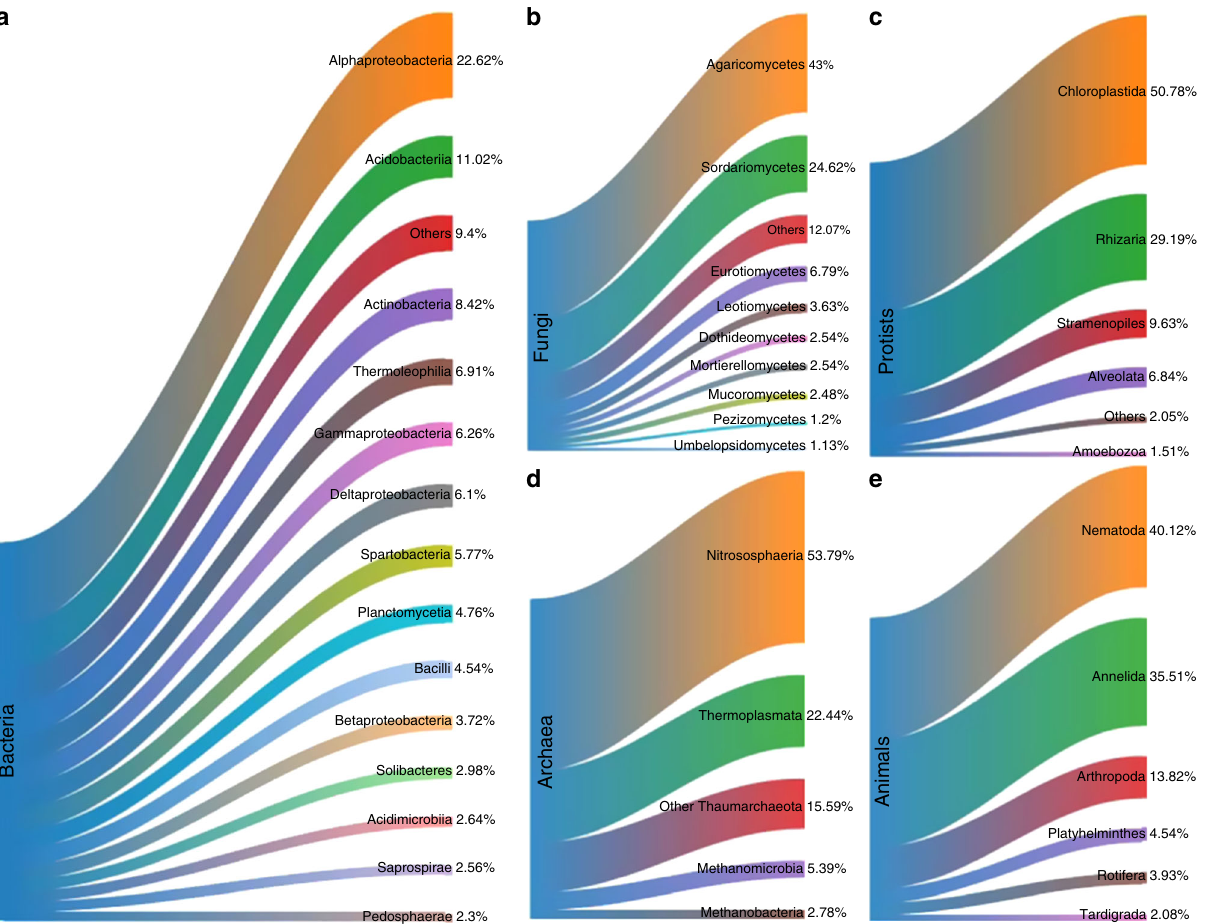
Fig. 1 Sankey diagrams of proportional abundances of OTUs from all samples for major soil biota groups. Arms denote proportions of OTUs at the class- level for a bacteria; b fungi; of major lineages of c protists; class-level for d archaea; and at the phylum-level for e animals. For information on how this fi gure was created, please see Supplementary